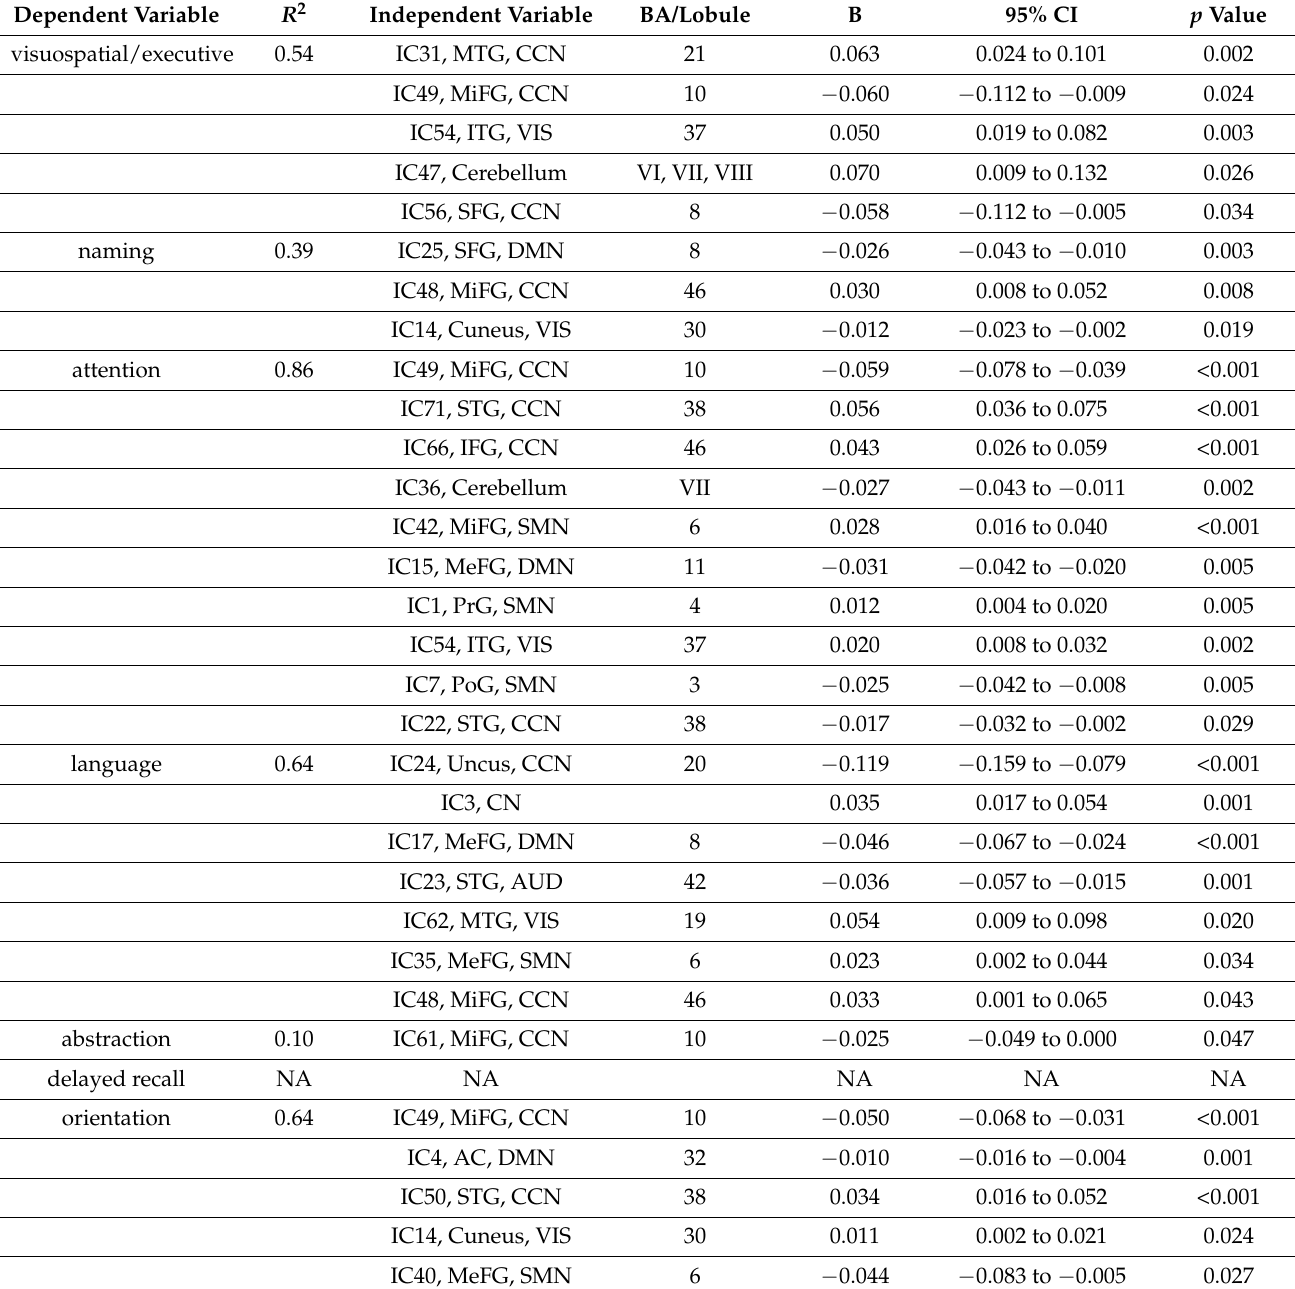
Table 2. Multiple regression analysis with each subdomain as dependent